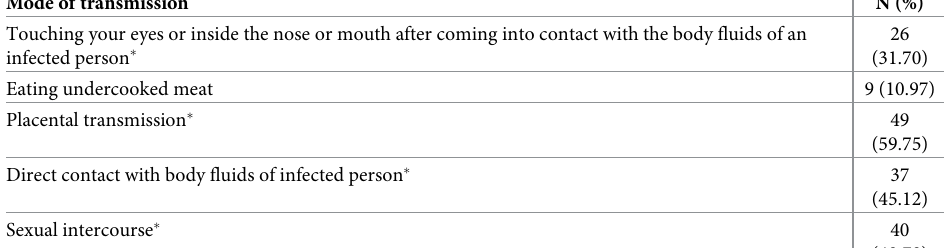
Table 2. Knowledge of CMV modes of transmission among survey respondents that previously heard of CMV. Mode of transmission N